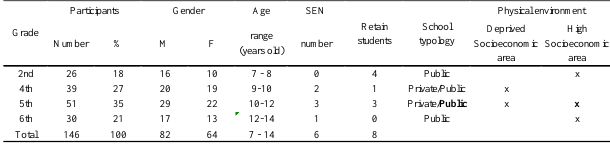
Table 1. Participating Study